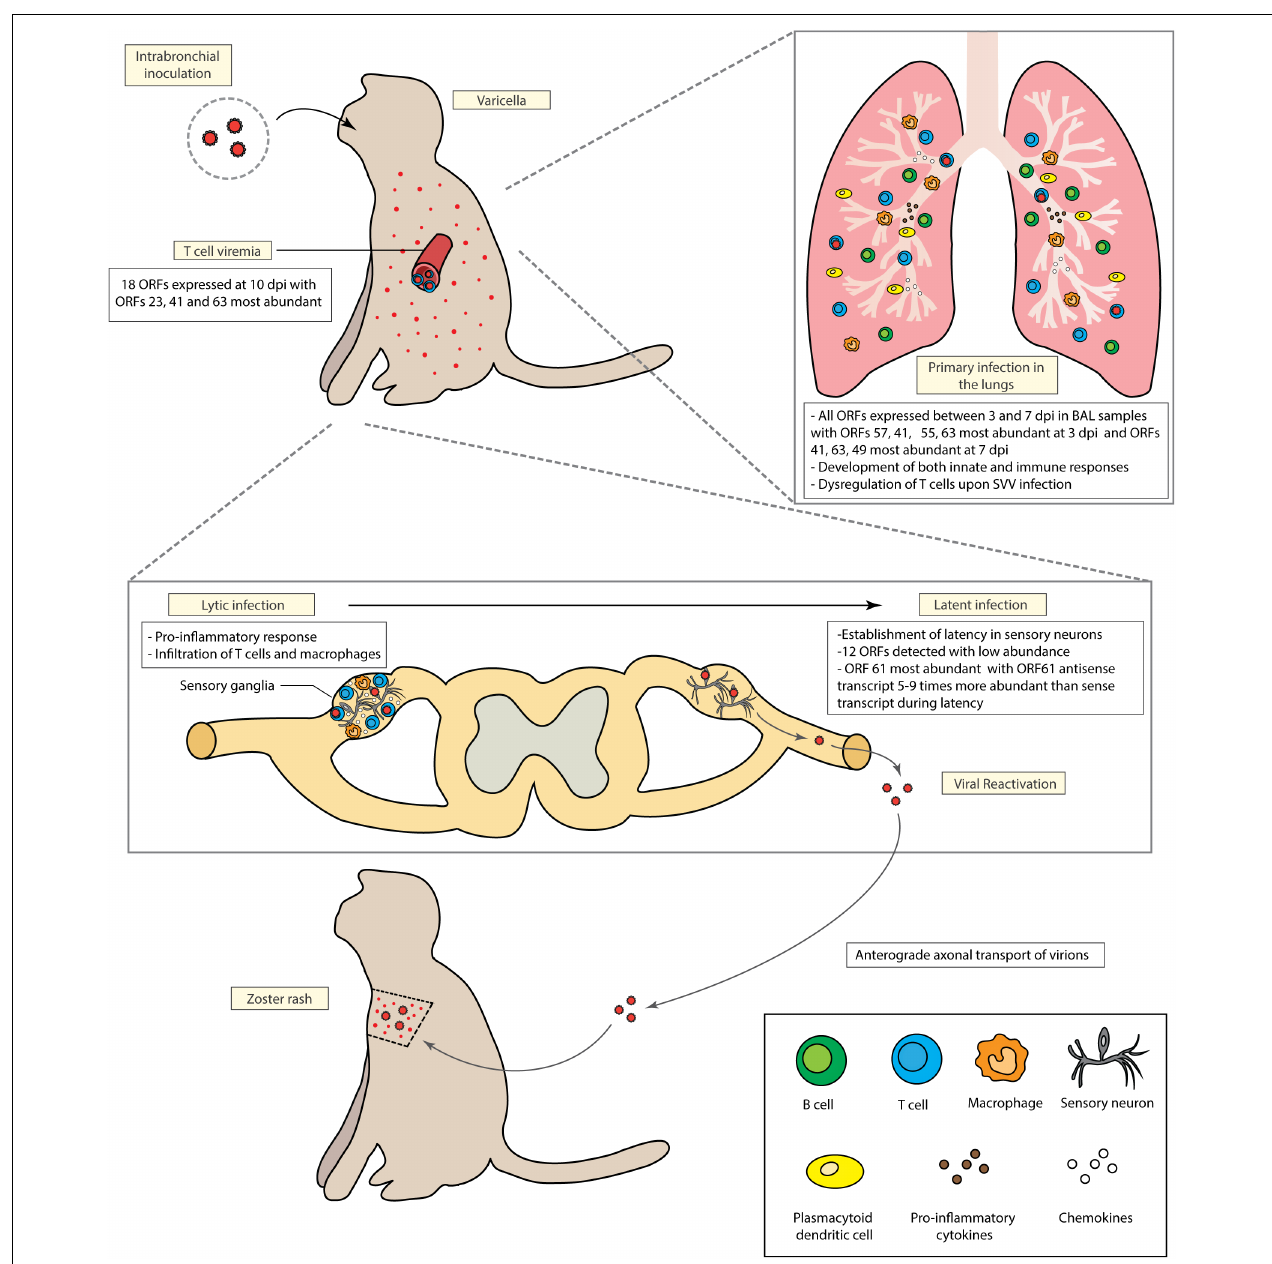
FIGURE 1 | Model of Simian Varicella Virus (SVV) pathogenesis in rhesus macaques following intrabronchial inoculation. Intrabronchial inoculation of rhesus macaques with SVV results in primary infection associated with viral replication in the lung, T cell viremia and the development of varicella. SVV reaches sensory ganglia as early as 3 days post infection. Initial viral replication is followed by the establishment of latency in the sensory ganglia. SVV can reactivate upon immune suppression. Both primary infection and viral reactivation induce robust cellular and humoral immune